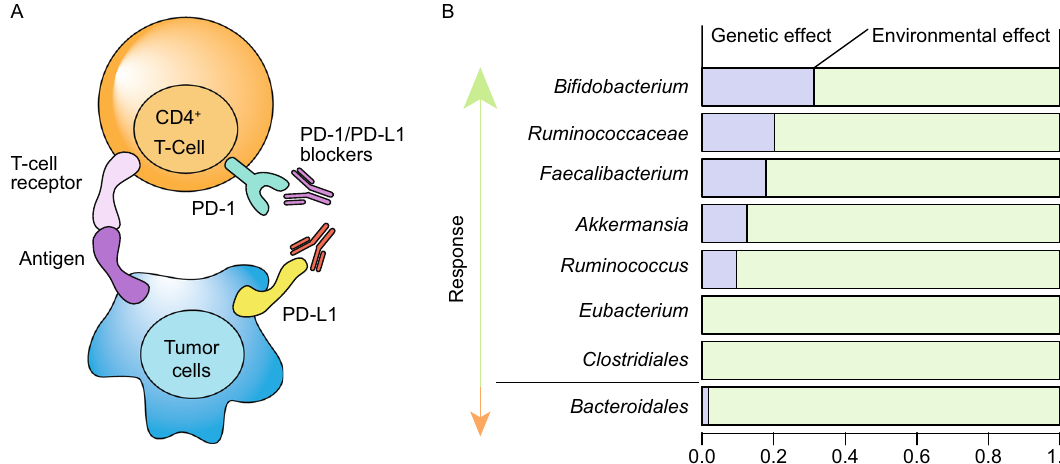
Figure 3. Gut microbiome associated with response of PD-1/PD-L1 based immunotherapy. (A) Checkpoints of immunotherapy. Programmed cell death protein 1 (PD-1) is a cell surface receptor that serves as an immune checkpoint. This receptor plays an important role in suppressing T cell in fl ammatory activity and down-regulating the immune system. Tumour cells can express PD-1 ligands (PD-L1) that are able to bind to PD-l protein and thus inactivate Tcells. Accordingly, several PD-1/PD-L1 blockers have been designed to block the interaction between PD-1 and PD-L1 to enable anti-tumour immunity. (B) Gut microbes associated with individual response of immunotherapy and the proportion of their variation explained by host genetics and environmental factors. Five bacterial taxa are associated to higher response, while bacteroidales is linked to low response. Inter-individual variation is scaled as 1 and the proportion of explained variation by genetic factors and environmental factors are shaded blue and green,